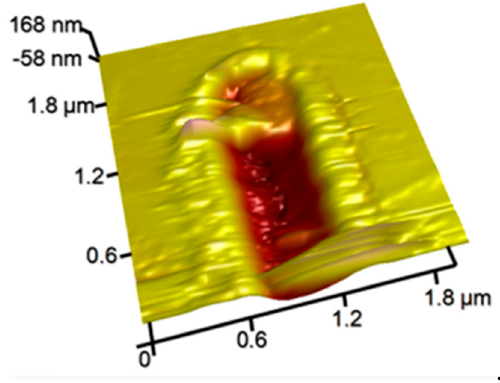
Figure 8. Nanochannel fabricated by two-step nanomilling approach [86].